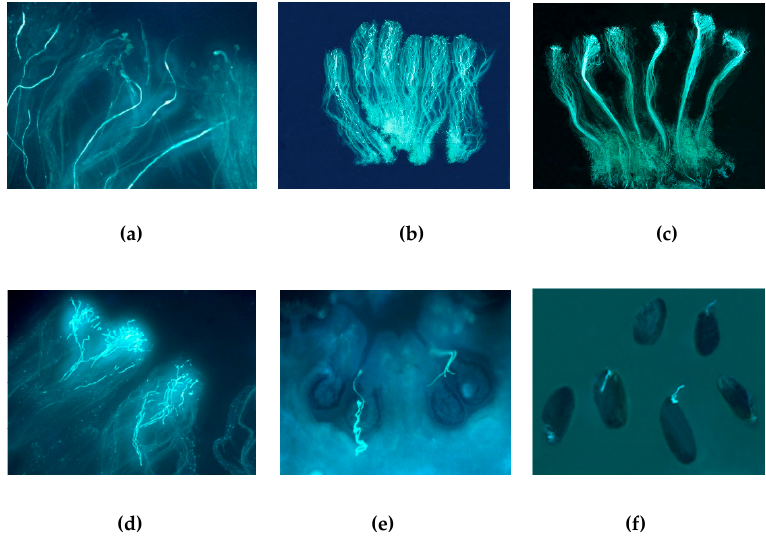
Figure 4. Pollen germination in the upper part of the style with the stigma—”Celina” × “Kristina”, 3 DAP ( a ); Pollen tube growth through separate styles—”Celina” × “Fritjof”, 6 DAP ( b ); Pollen tubes entering the basal part of the styles—”Ingeborg” × “Anna”, 9 DAP ( c ); Incompatible pollen tubes in the upper part of the style—”Ingeborg” × “Conference”—6 DAP ( d ); Penetrated pollen tubes into the locules of the ovary—”Ingeborg” × “Clara Frijs”, 9 DAP ( e ); Fertilized ovules—”Celina” × “Kristina”, 12 DAP ( f ).